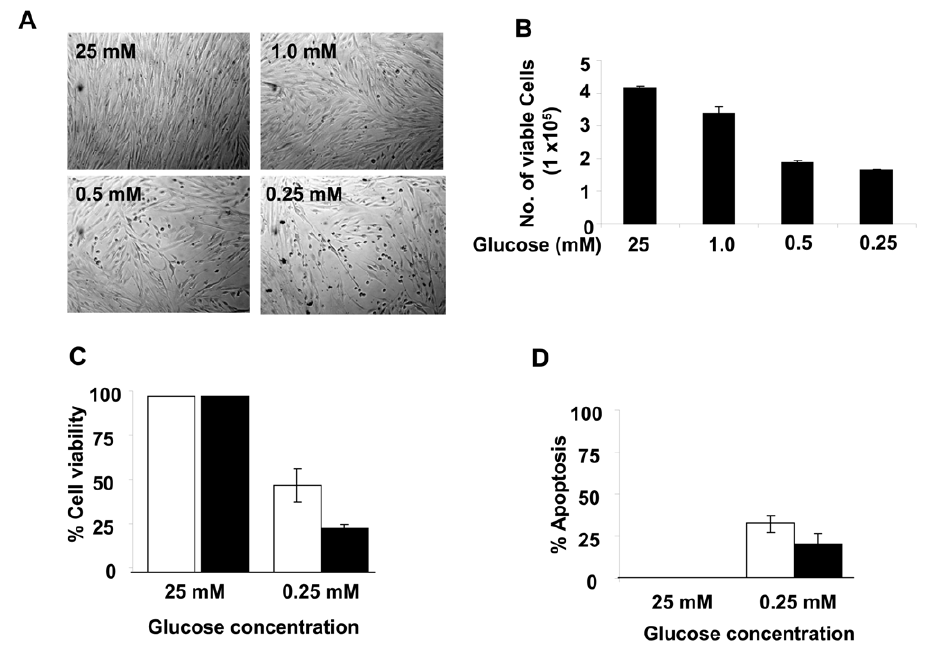
Figure 3. Glucose restriction decrease cell survival. ( A ) Sub-confluent cultures of young WI-38 HDFs were incubated with the indicated concentrations (mM) of glucose in the medium supplemented with 10% fetal bovine serum for 24 h. At the end of the incubations, cells were photographed using a phase contrast microscope. ( B ) At the end of the incubation of HDFs shown in the panel (A), the number of viable cells were counted (in triplicates) by Trypan Blue exclusion method using the Countess Automated Cell Counter (Invitrogen). ( C and D ) HDFs (in triplicates) were grown in 96-well plates and cells were incubated at the indicated concentrations of glucose for either 24 h (white bars) or 48 h (black bars). At the end of the incubations, cell viability and the extent of apoptosis were determined using ApoTox-Glo Triplex Assay (Promega) as described in the method. Experiments were repeated three times, which gave similar results.